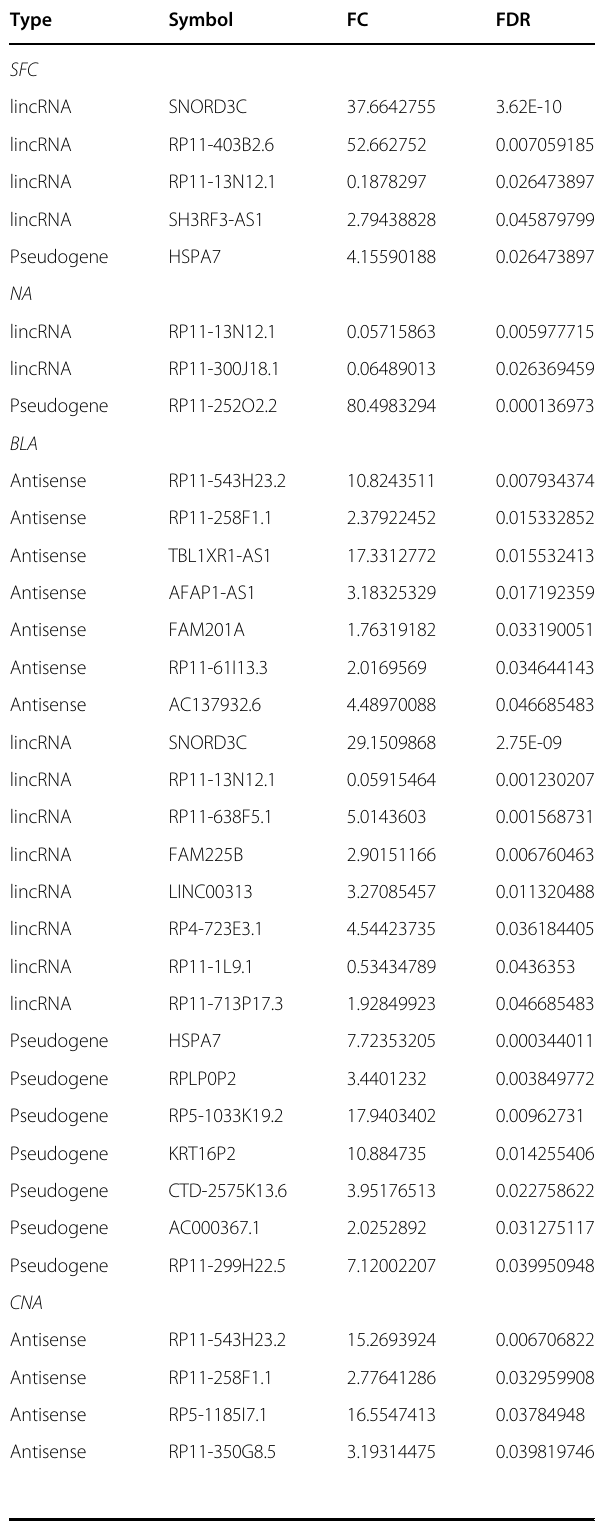
Table 2 Long noncoding RNAs altered in alcohol use